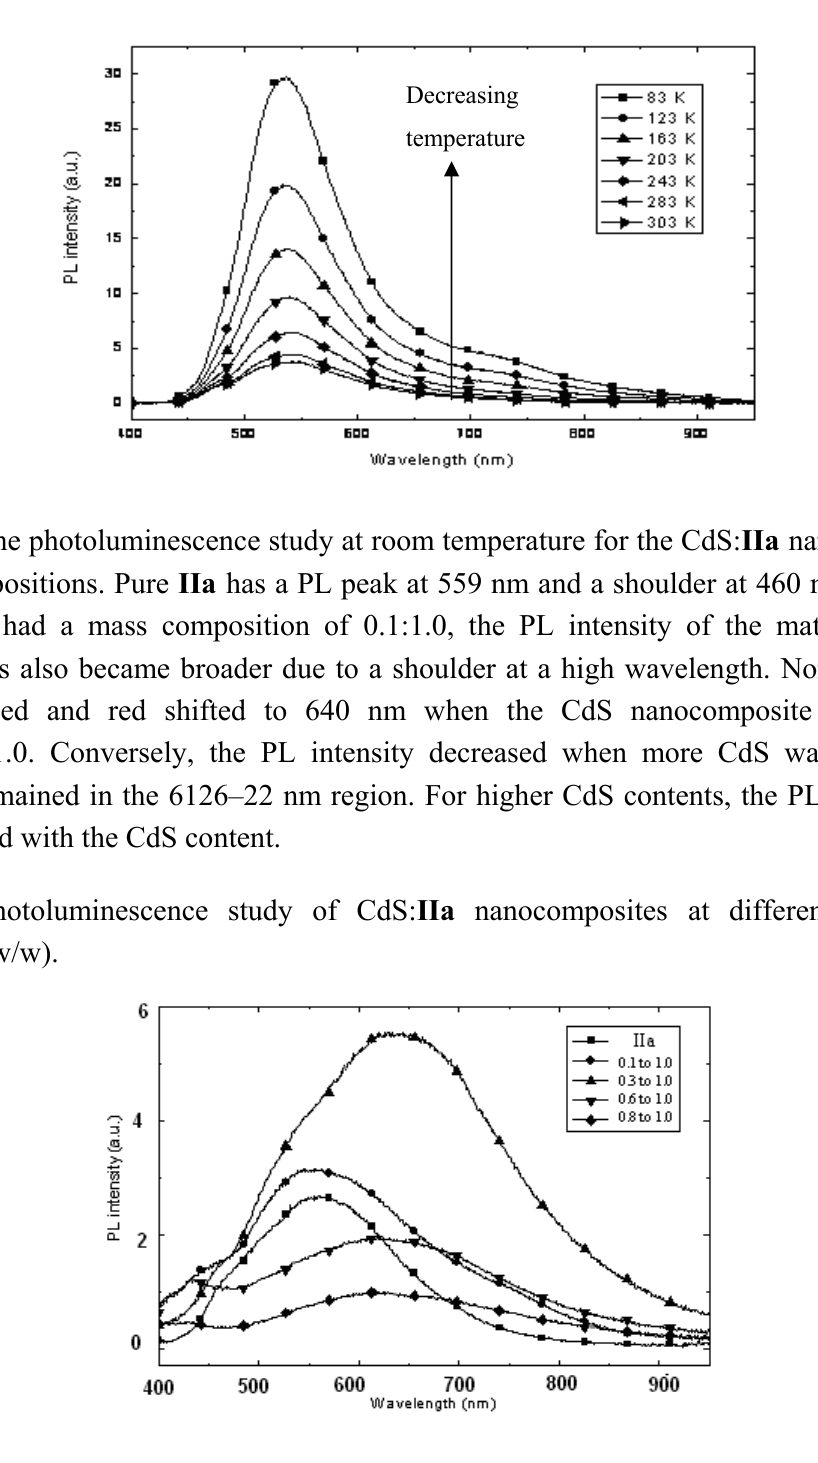
Figure 10. Temperature dependence of the PL of CdS: Ia nanocomposite at 0.2:1:0 (w/w).